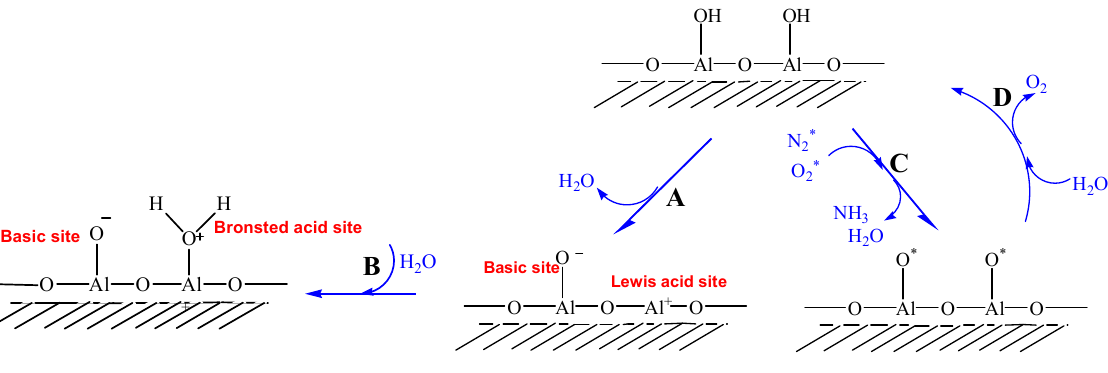
Figure 5. Scheme of surface reactions when the support (Al as example) is dehydrated, hydrated, or exposed to NTP-air.